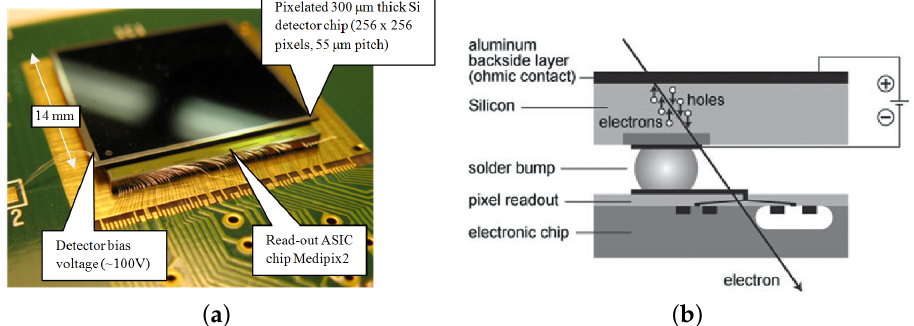
Figure 1. ( a ) Medipix device operated at LHC Run-1. ( b ) Schematic view of the functionality of the hybrid pixel detectors.